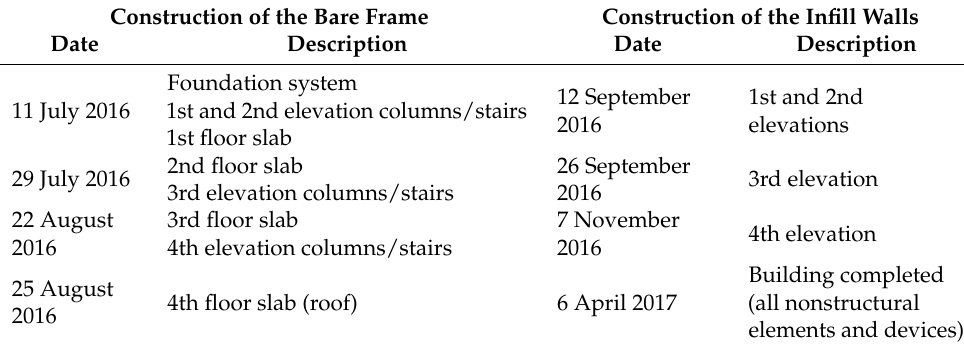
Table 2. Description of the construction phases of the building case study. Construction of the Bare